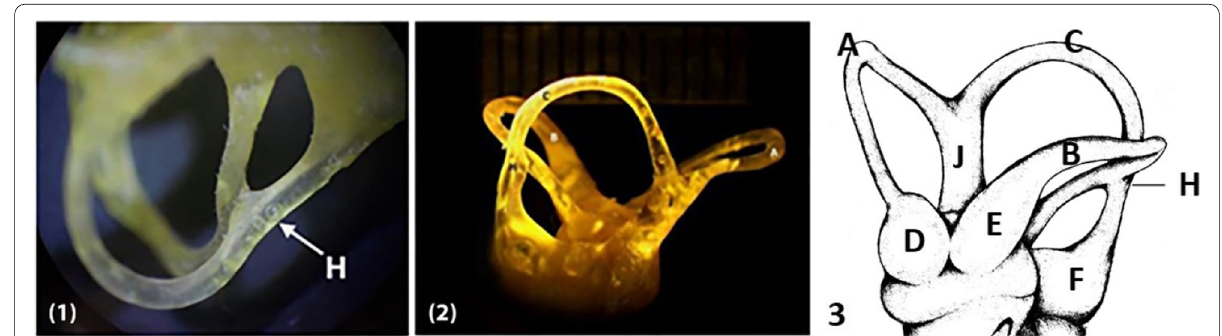
Fig. 8 (1 and 2) Corrosion cast from plastic material of a camel semicircular canal. (3) Diagram showing the shape of the three semicircular canals of the camel. A. anterior semicircular canal, B. lateral semicircular canal, C. Posterior semicircular canal, D. ampulla of anterior semicircular canal, E. ampulla of lateral semicircular canal, F. ampulla of posterior semicircular canal, H. Confluence between posterior and lateral semicircular canal, J. common